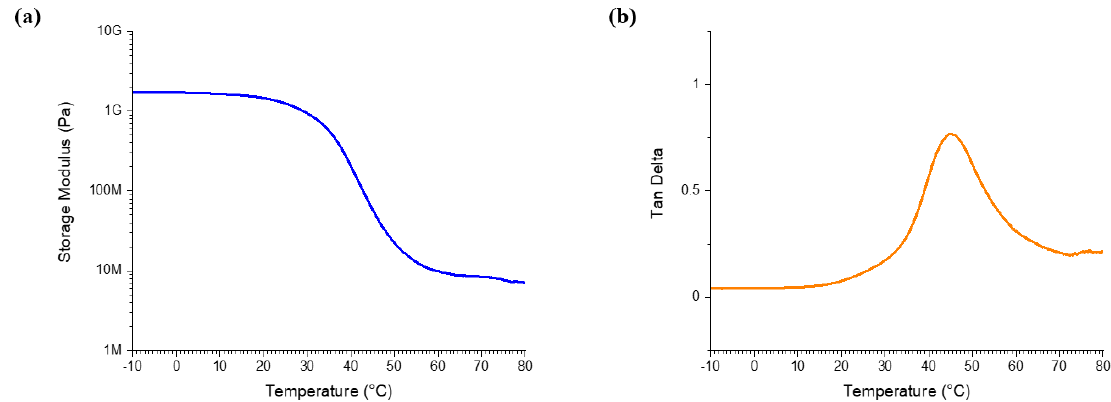
Figure 2. The characterization of shape memory polymer (SMP): ( a ) Storage modulus and ( b ) Loss factor (Tangent δ ).